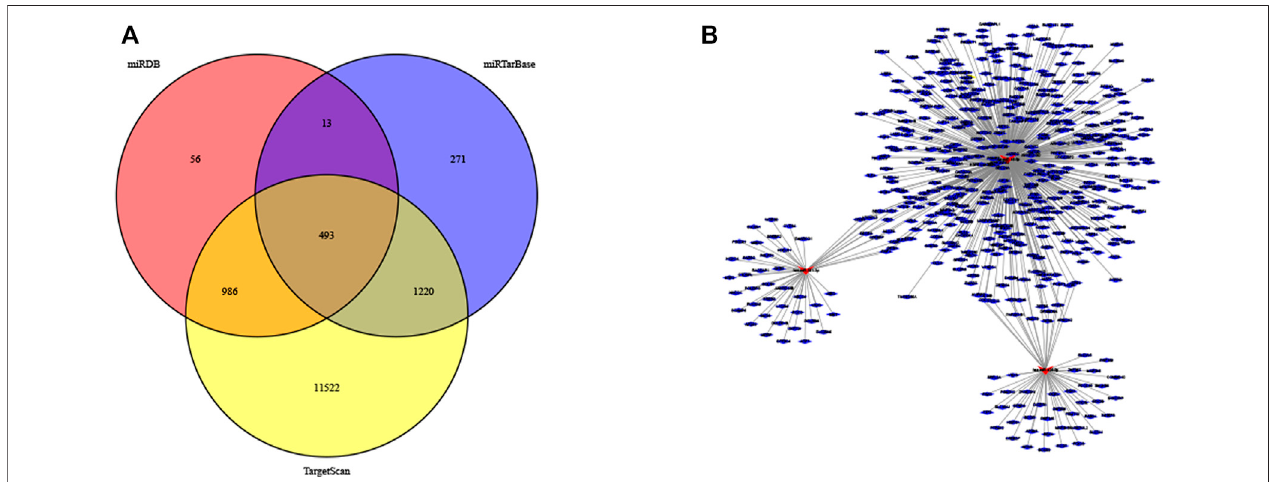
FIGURE7| MiRNAtargetgenesofthethreeDENSMs. (A) TheVenndiagramofDENSMsbythreepredictionwebsites(miRDB,miRTarBase,TargetScan). (B) The network of DENSMs made by Cytoscape.